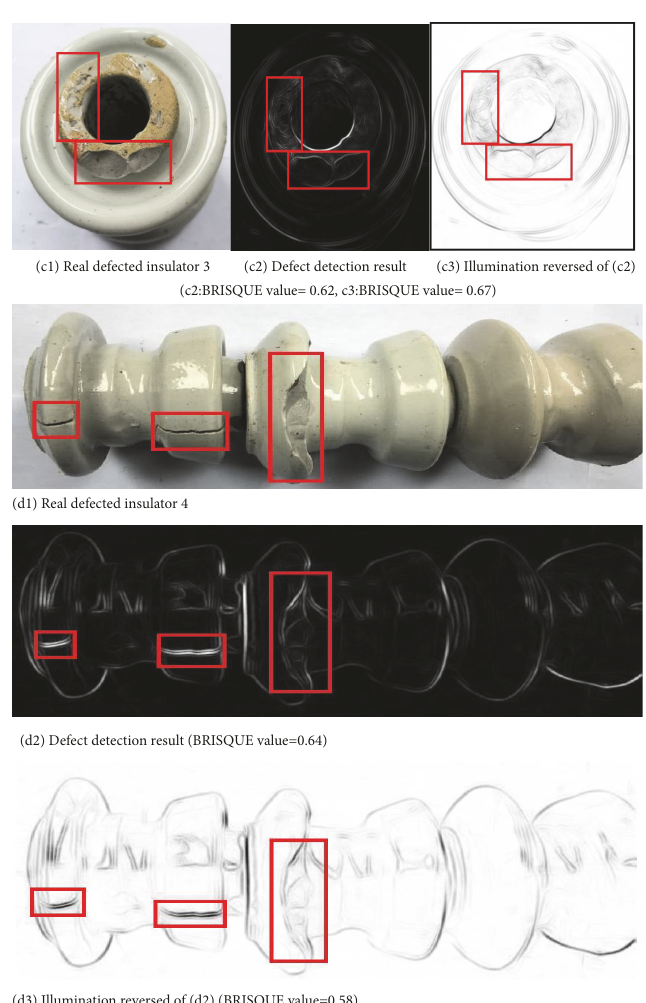
Figure 7: Real defected detection of ceramic electrical